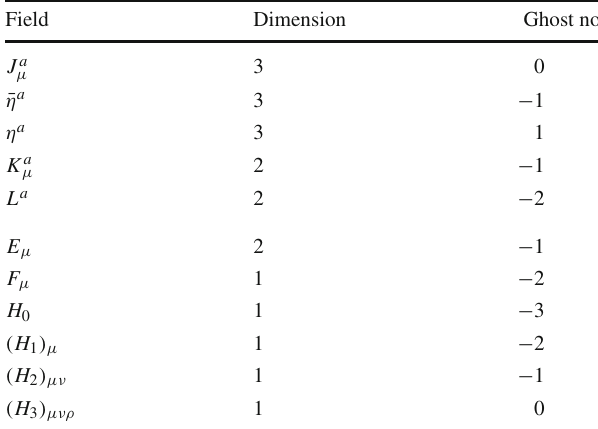
Table 1 Properties of the source fields